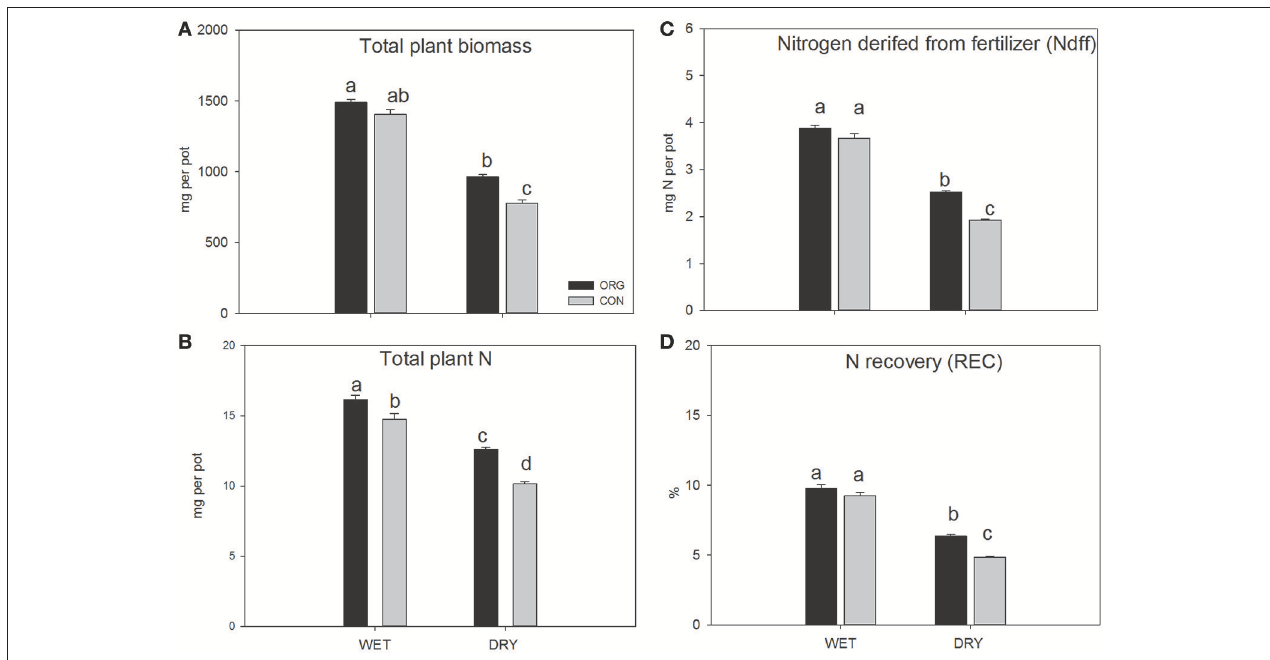
FIGURE 2 | Effects of farming system (FS) and water regime (WR) on total plant dry weight biomass (A) , total plant nitrogen (N) (B) , N derived from fertilizer (Ndff) (C) and total N recovered from fertilizer (REC) (D) of ryegrass (shoot and root) after 15 N labeled green manure amendment (plant nutrition experiment). Ryegrass was grown in organically (ORG) and conventionally (CON) managed soils for 56 days under controlled WET and DRY conditions. Two-way ANOVA and Tukey post hoc tests were applied to identify differences between treatments indicated with different letters. n = 6; error bar represent standard errors.